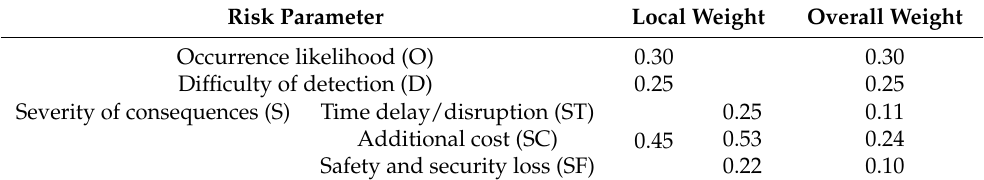
Table 2. Risk parameters’